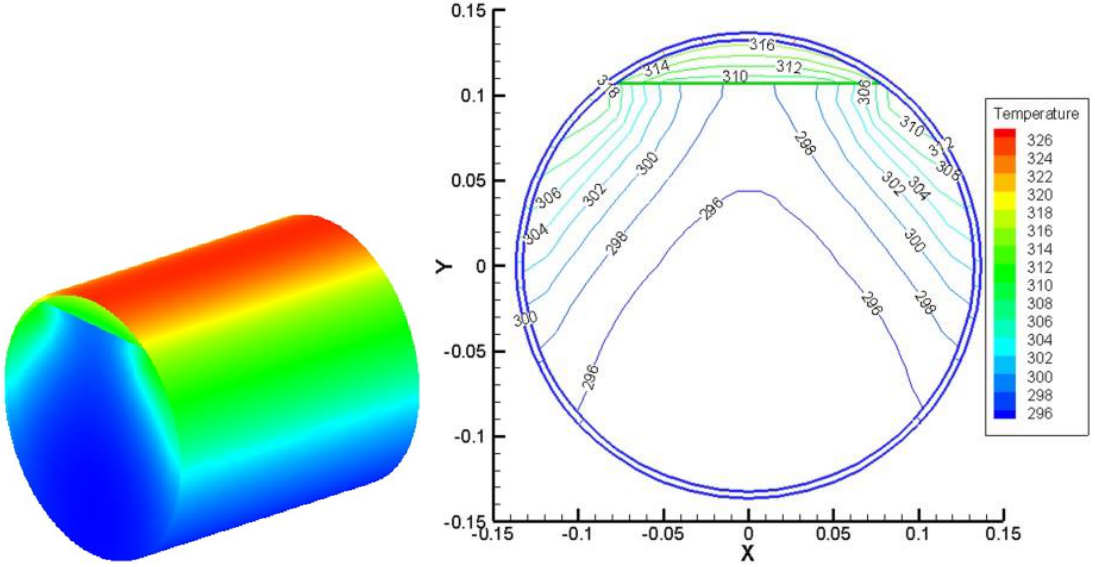
Figure 3. Temperature cloudy map and isopleth in Model 2 (unit: K).